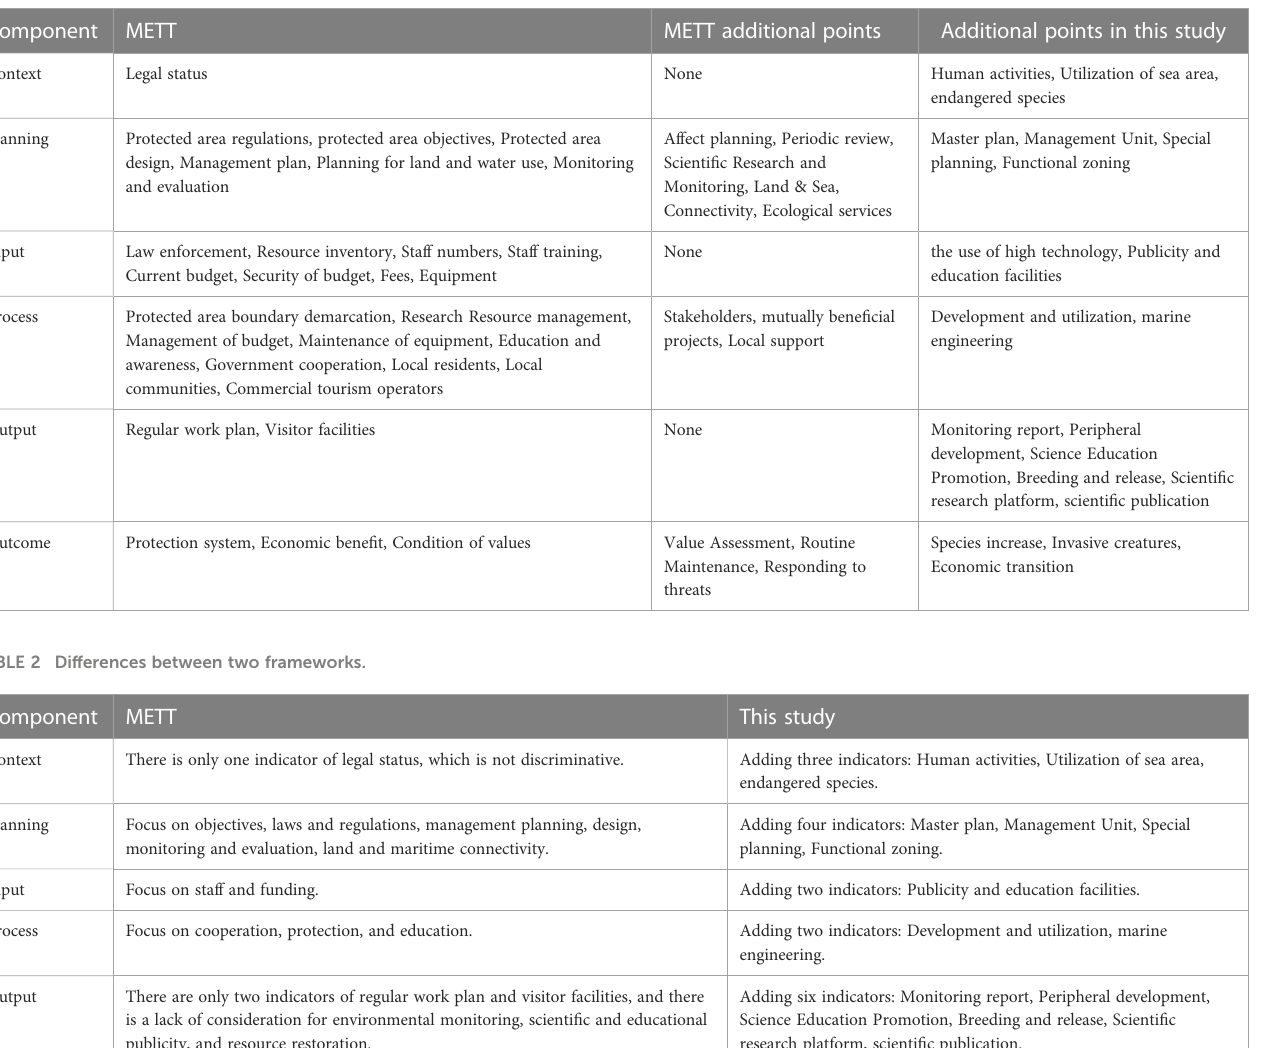
TABLE 1 East China Sea marine reserves management effectiveness assessment system.